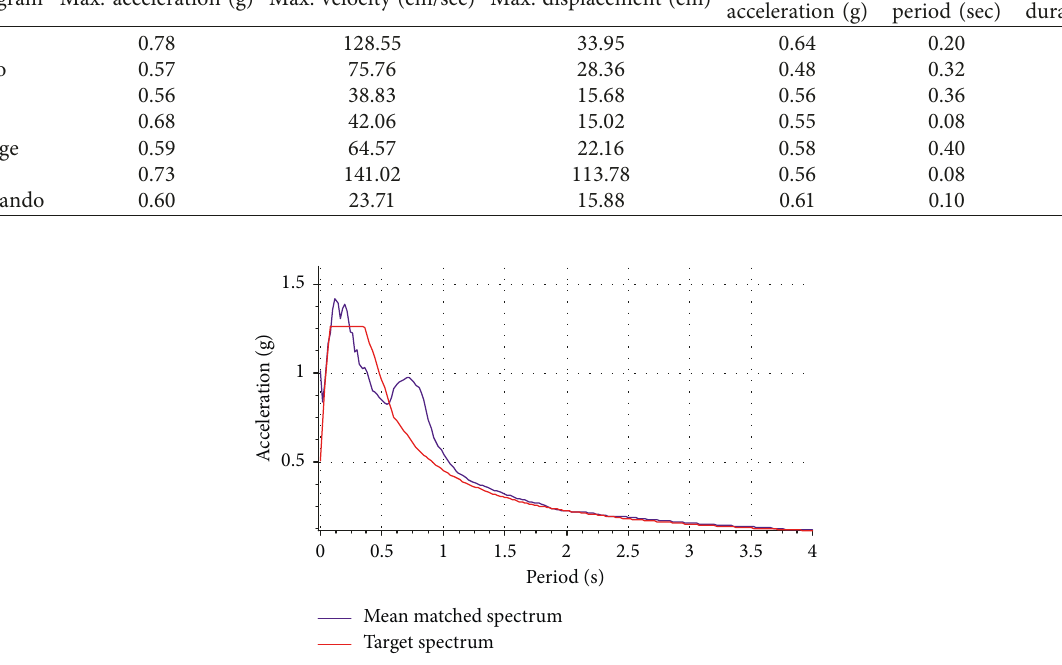
Figure 9: Mean matched spectrum compared to the target spectrum. Table 5: Crossover and mutation